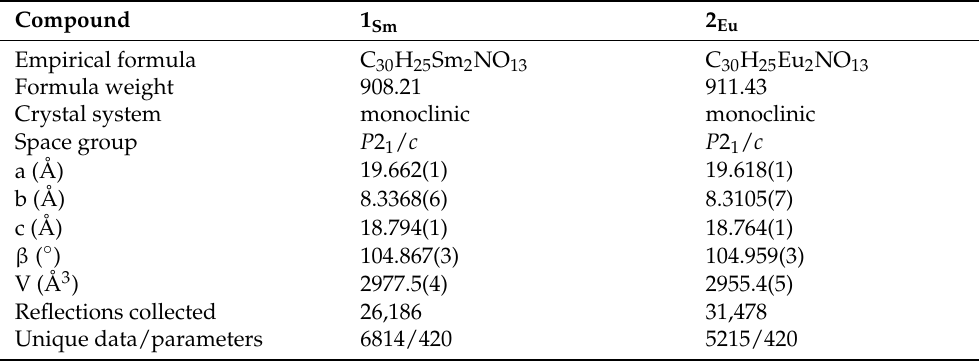
Table 1. Single crystal X-ray diffraction data and structure refinement details of compounds 1 Sm and 2 Eu